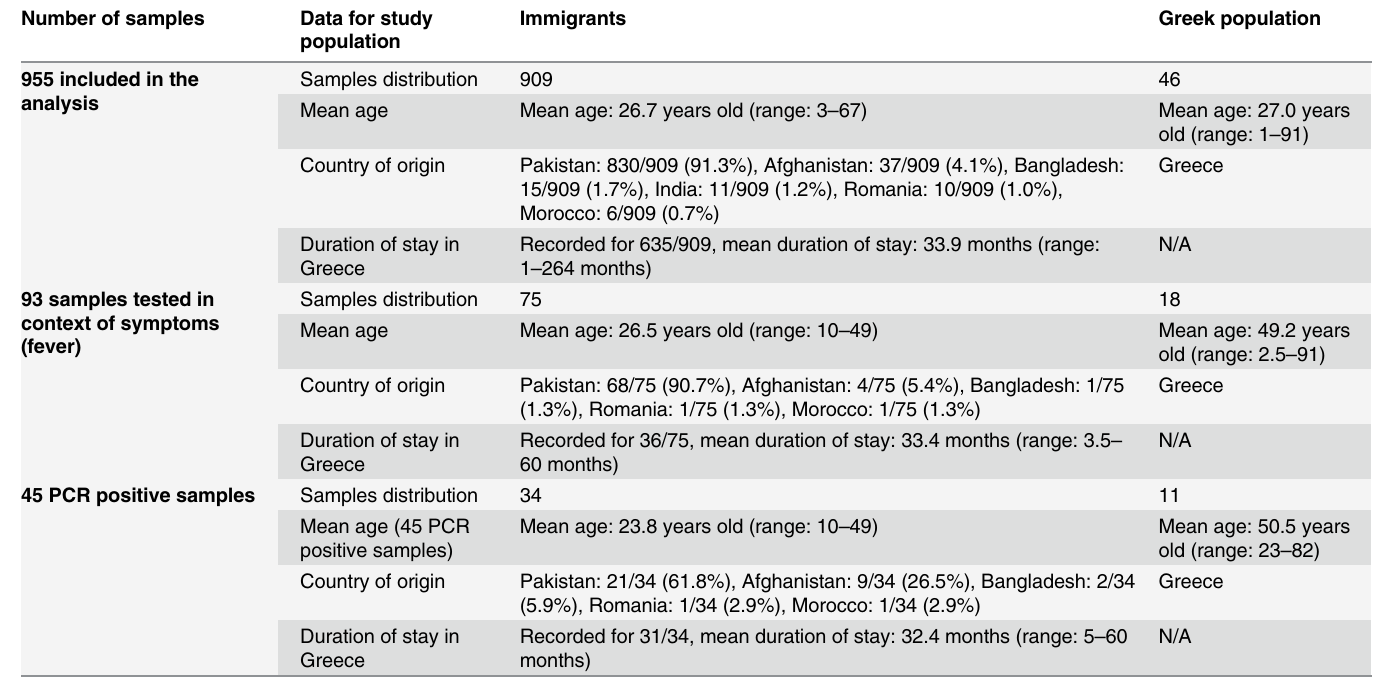
Table 1. Description of samples included in the